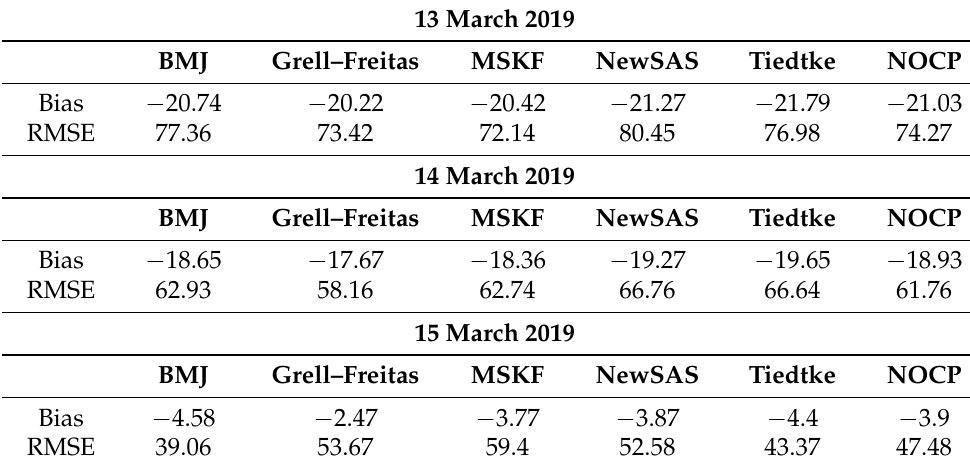
Table 3. The Mean Error and Root Mean Square Error (mm) for the three days of the case study, for WRF simulations with no-convection scheme and with five convection schemes calculated for the red rectangle in Figure